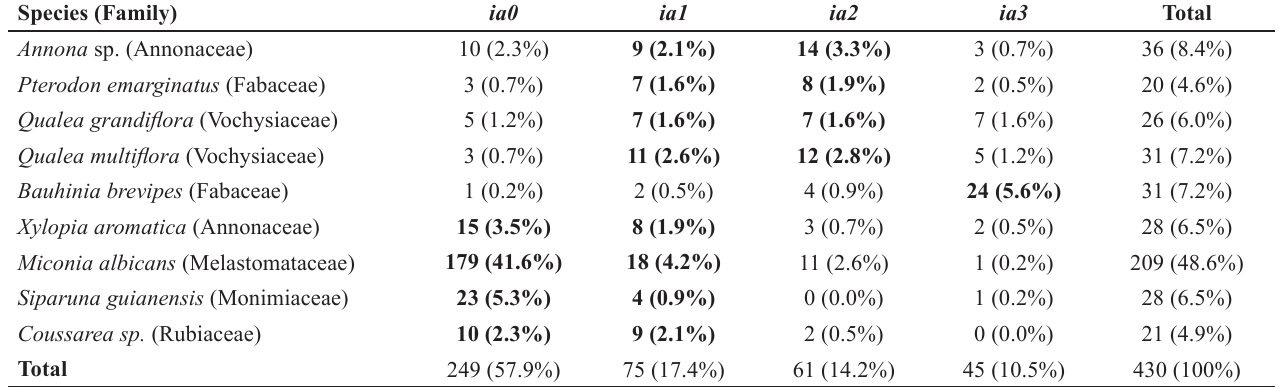
Table 4. Abundance and percentage of plant individuals found in the categories of termite attack intensity in the nine vegetal species represented by 20 or more individuals in the sampling in the Estação Ecológica de Pirapitinga - Minas Gerais. Bold indicates the most observed levels of attack intensity in each group.